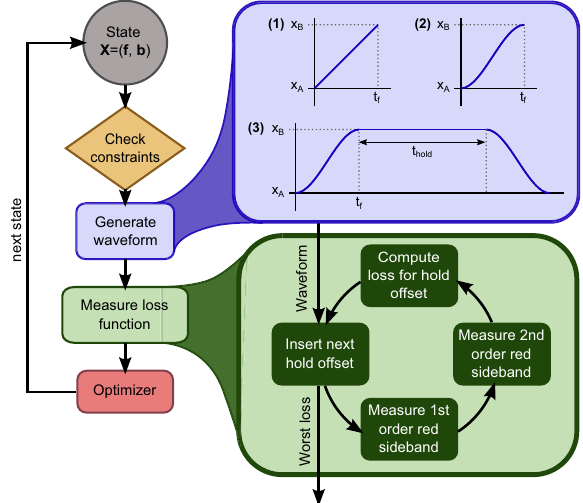
Fig. 2 Optimization procedure. Given an optimization state X = ( f , b ), the constraints on the state are fi rst checked and if satis fi ed are used to generate the waveform from the base solution (1). This is achieved by scaling the axial frequency and modifying the trajectory to realize the forward transport solution (2). The full waveform consists of the forward solution followed by a hold and then followed by the time reversal of the forward waveform to return the ion to position A (3). The loss function consists of a loop over a set of DAC offset steps that are inserted into the hold time. The loss is calculated for each offset by measuring the fi rst- and second-order red sidebands. The fi nal loss is the worst performing of these offset losses and is sent to the optimizer which generates the next trial